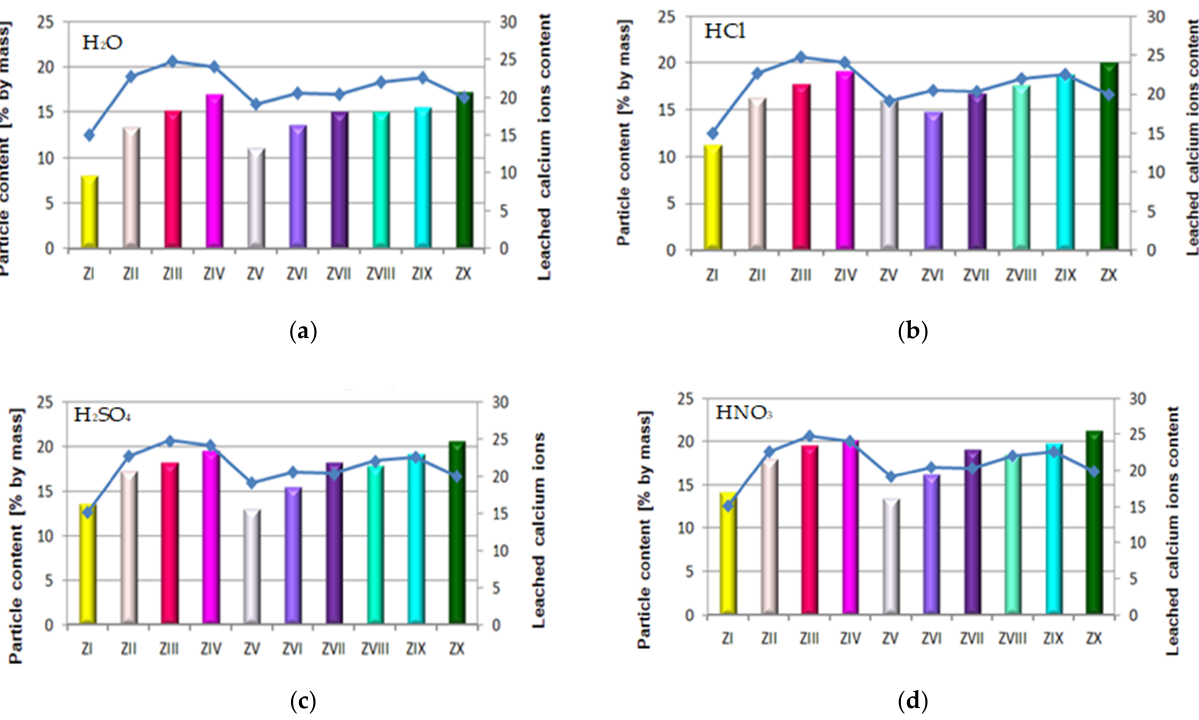
Figure 15. Relation between quantity of leached calcium ions (Ca 2+ ) and content of particles >100 μm in mortars containing FBC fly ashes and CFA in different environments: ( a ) in H 2 O, ( b ) in HCl, ( c ) in H 2 SO 4 , ( d ) in HNO 3 .